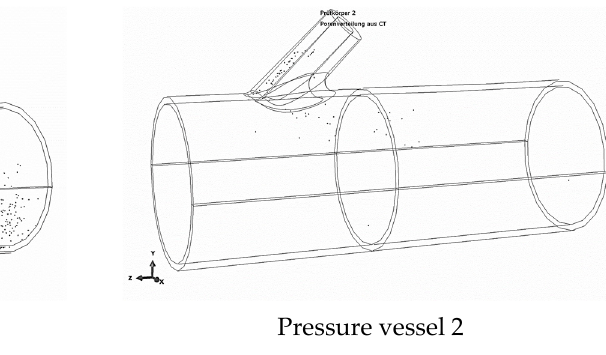
Figure 3. Evaluation of pore distribution and size in the two additively manufactured model pressure vessels [20].